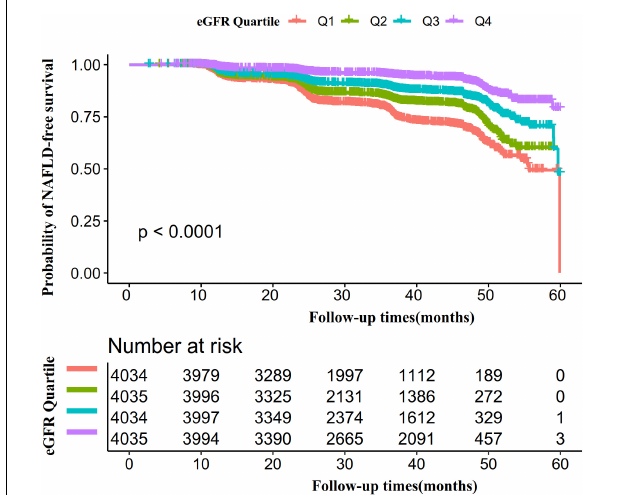
FIGURE 6 | Kaplan–Meier event-free survival curve. The probability of NAFLD-free survival differed significantly between the eGFR groups (log-rank test, p < 0.0001). The probability of NAFLD-free survival gradually increased with increasing eGFR, suggesting that the group with the highest eGFR had the lowest risk of NAFLD.